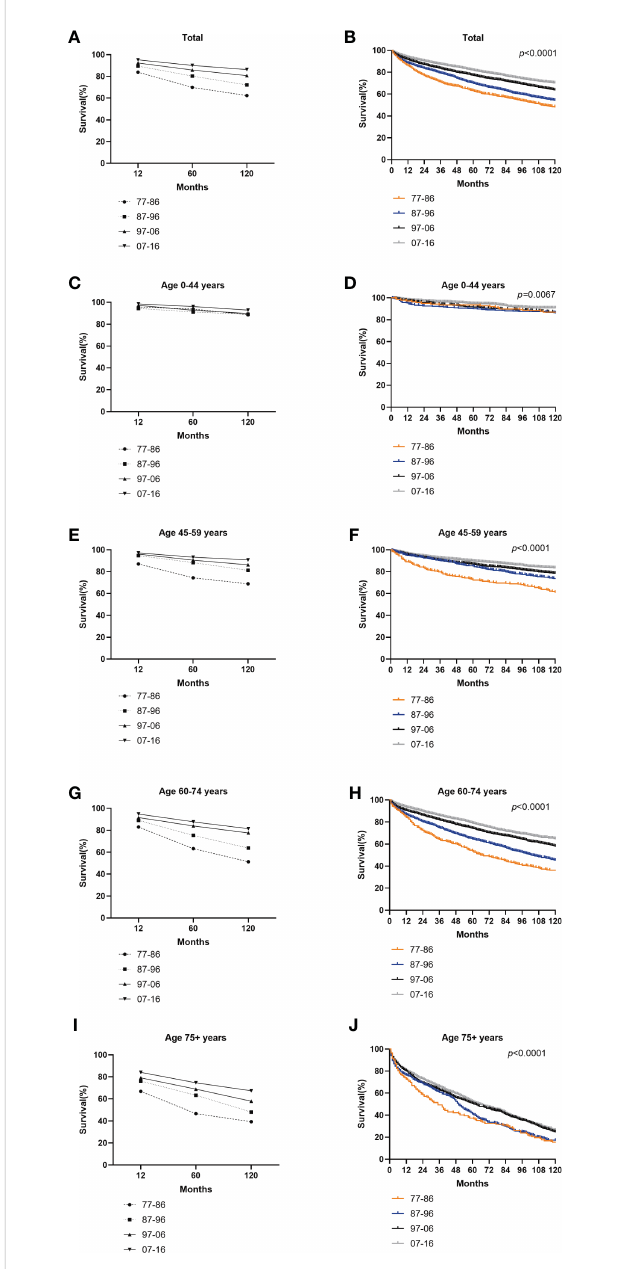
FIGURE 4 Trends in 10-year relative survival (A, C, E, G, I) and Kaplan-Meier survival analysis (B, D, F, H, J) for PATIENTS with GI-NETs during 1977- 1986 (orange), 1987-1996 (blue), 1997-2006 (black), and 2007-2016 (gray), grouped by age (total and age 0-44 years, 45-59 years, 60-74 years and over 75